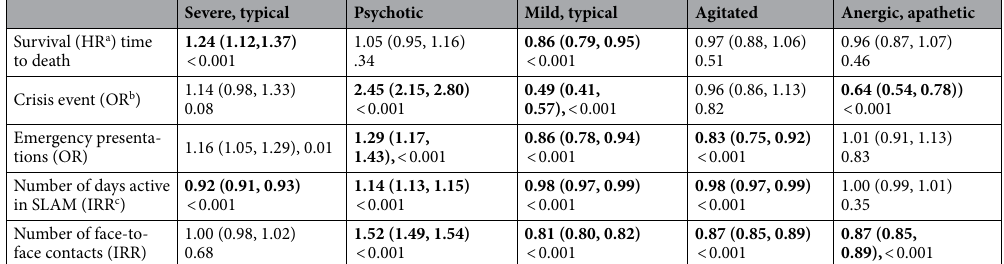
Table 2. Strength of the association, adjusted, between various outcomes with each symptom group versus the rest of the sample. *Adjusted for age, gender, ethnicity, and index of multiple deprivation score. a Hazard ratio. b Odds ratio. c Incidence rate ratio. Statistically significant results are bolded. [HR/ OR/ IRR (95% CI), P -value].